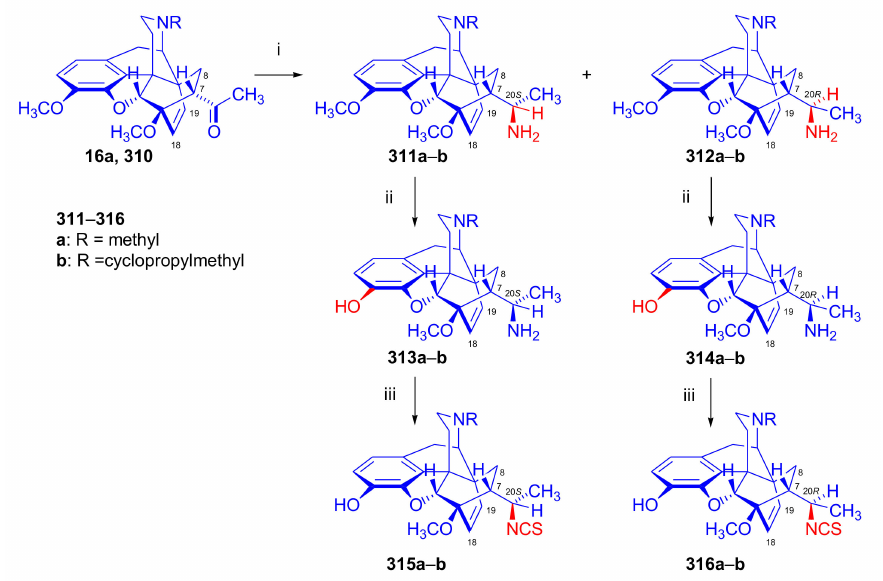
Figure 82. Synthesis of diastereomeric 20-isothiocyanato-6,14-ethenomorphinan derivatives. Reagents and conditions : (i): sodium cyanoborohydride, ammonium acetate, MeOH, 3 days; (ii): KOH, diethy- lene glycol, 210 ◦ C, 140 min; and (iii): thiophosgene, NaHCO 3 , CH 2 Cl 2 , RT, 80